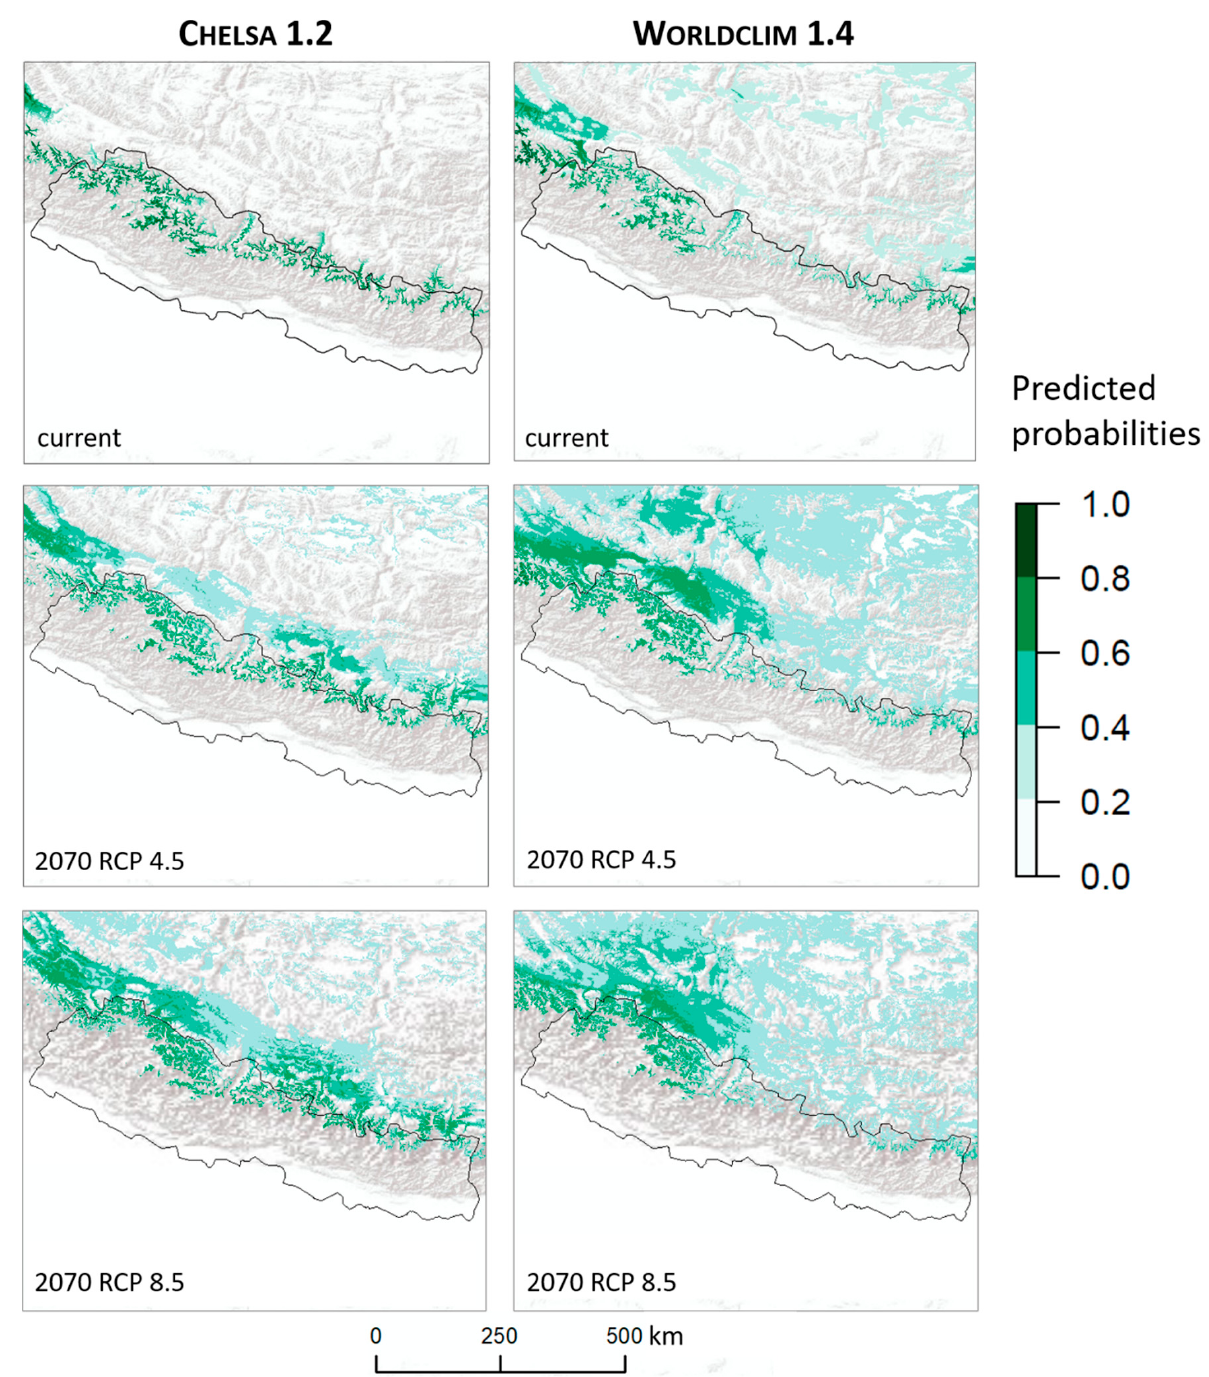
Figure 7. Comparison of model projections for the potential distribution of Betula utilis under current and future climate conditions for C HELSA 1.2 and W ORLDCLIM 1.4 climate datasets under RCPs 4.5 and 8.5, respectively. For C HELSA 1.1, no future climate scenarios are available, whereas for W ORLDCLIM 2.1, future scenarios are currently only available at coarser resolution (>30 arc seconds).